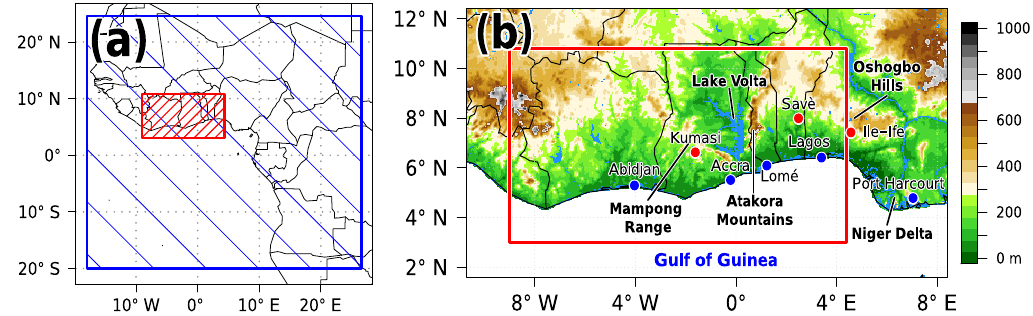
Figure 1. (a) Modeling domain SWA (red rectangle, 2.5km grid mesh size) together with its coarse domain (blue, 5km grid mesh size). (b) Map of the research area SWA. The color shading denotes topography (meters above sea level; ma.s.l.). Topographic features are named in bold, coastal cities are shown as blue dots and the three DACCIWA supersites as red dots. Lamto (magenta dot), together with Abidjan, is used for evaluations of relative humidity profiles. The modeling domain SWA is again denoted as a red rectangle. The orange rectangle highlights the domain over the Ivory Coast, which is used for subsequent analyses. Figure adopted from Deetz et al. (2018).